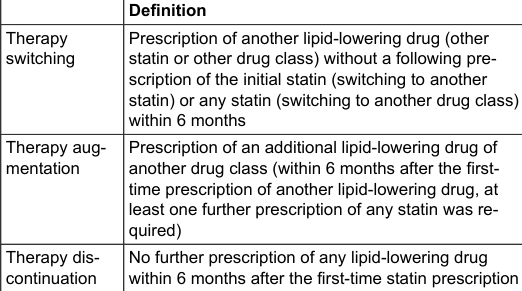
Table 2: Definitions of therapy switching, augmentation, and